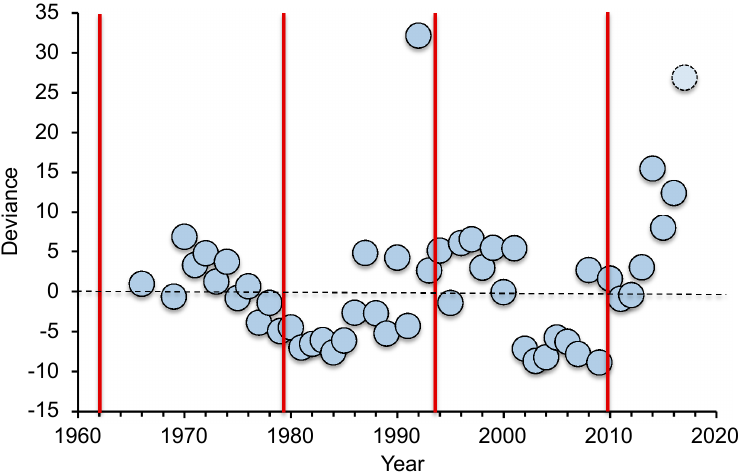
Figure 1. Interannual variation in the number of crown-of-thorns starfish (CoTS) publications relative to the start of successive outbreaks on Australia’s Great Barrier Reef (as indicated by vertical red lines). The annual number of publications was determined based on a Web of Science search (topic = “ Acanthaster ” or “crown-of-thorns” and “Australia”), which was then detrended (showing the deviance from a linear regression between annual number of publications and year from 1965 to 2016) to account for increases in the number of publications through time. NB. Number of papers for 2017 is projected, based on number of papers published to end of April, 2017.